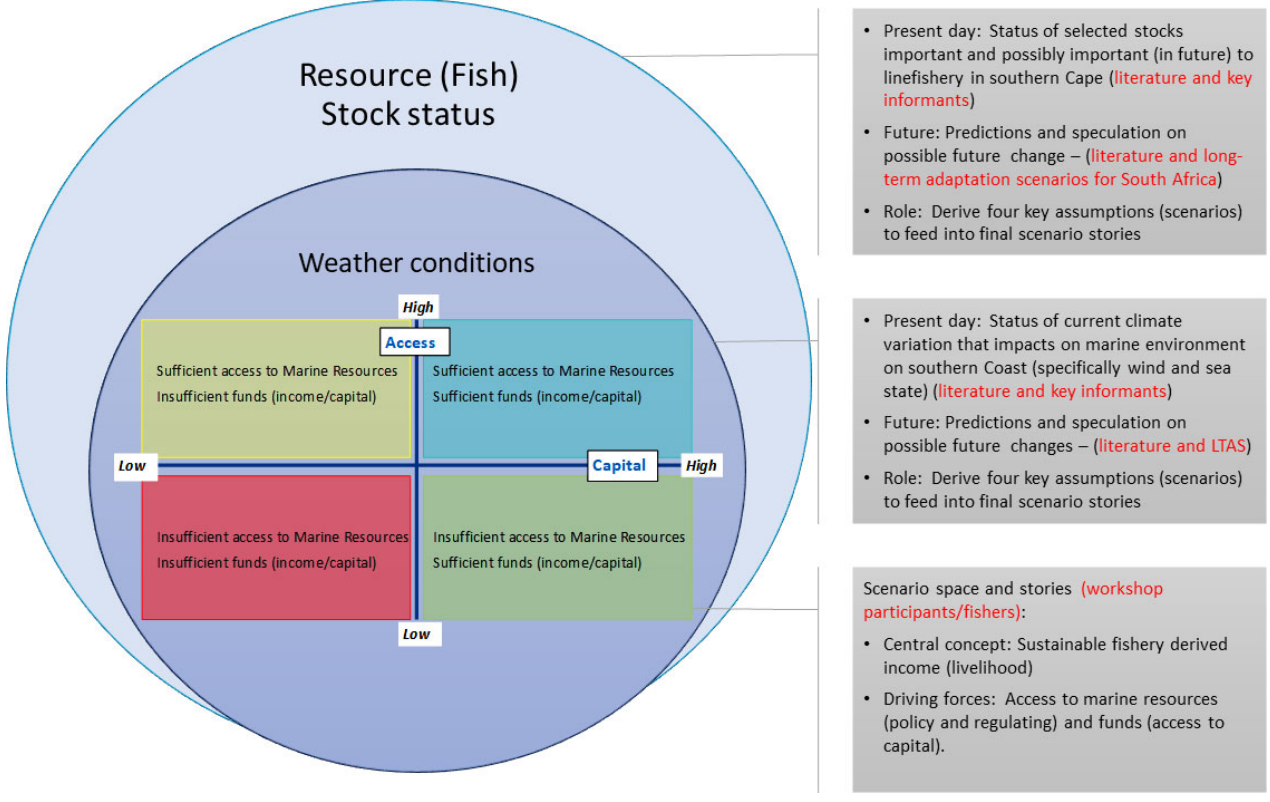
Fig. 4 . Schematic of the methodology used to derive the final scenario stories. Participant-derived scenarios relating to access to fishing rights and capital were backdropped with additional drivers, i.e., climate change (in the context of prevailing weather conditions) and resource status (in the context of current pervasive fish scarcity in the area and expected distributional changes with climate change). Data sources are highlighted in red. LTAS = long-term adaptation